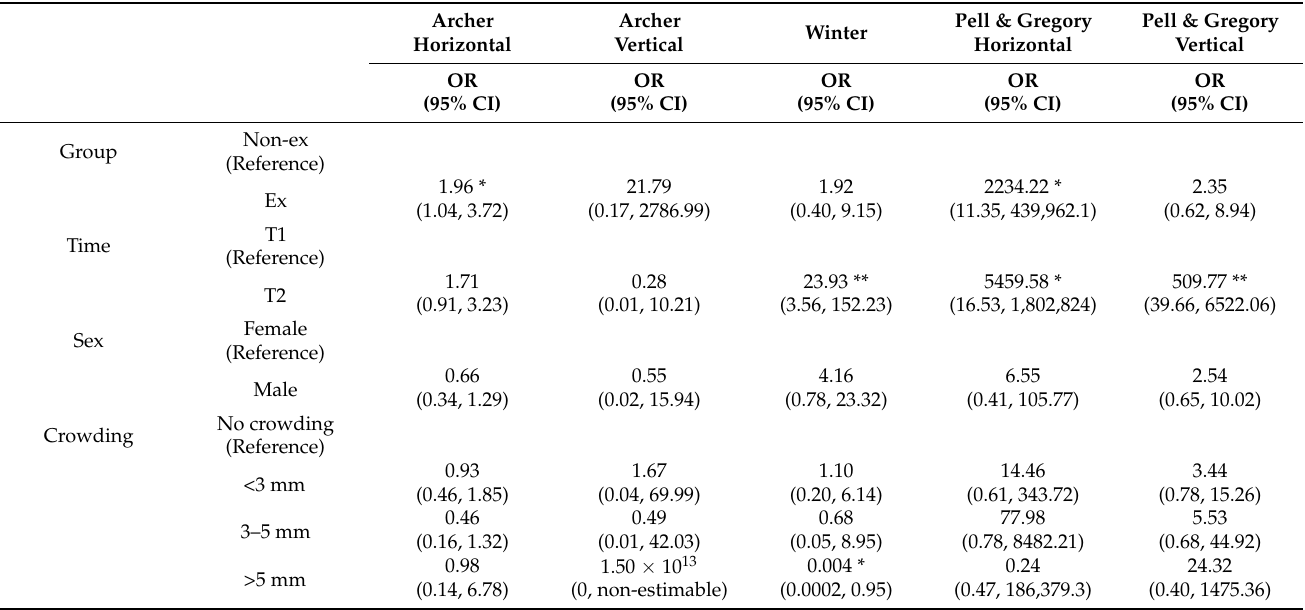
Table 3. Odds ratios and 95% confidence intervals from the random effects analysis for the different classification systems (Archer, Winter, Pell &